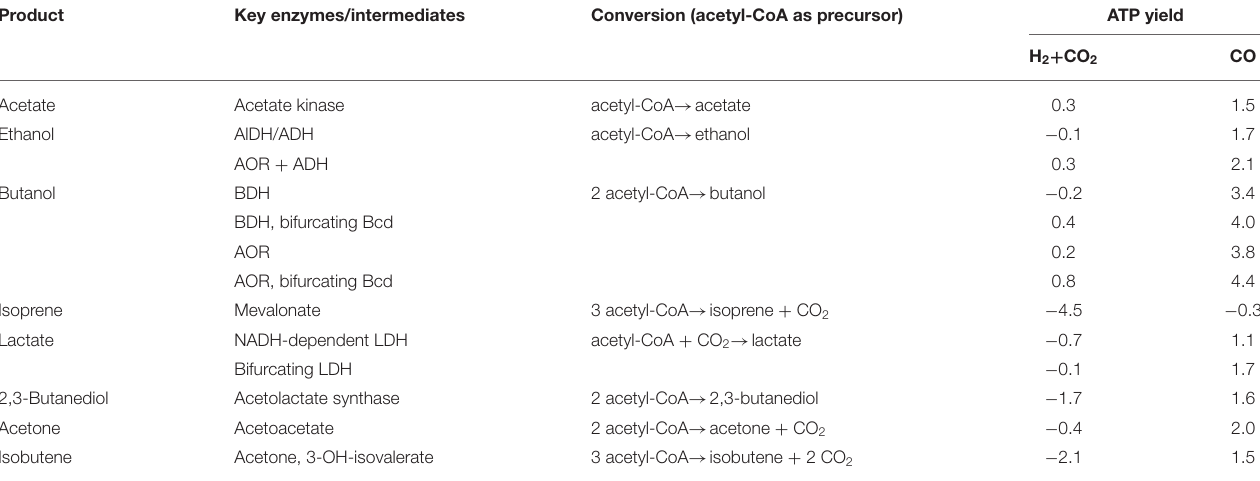
TABLE 1 | ATP yield for the synthesis of products from acetyl-CoA with H 2 + CO 2 or CO as electron donor in A. woodii . Product Key